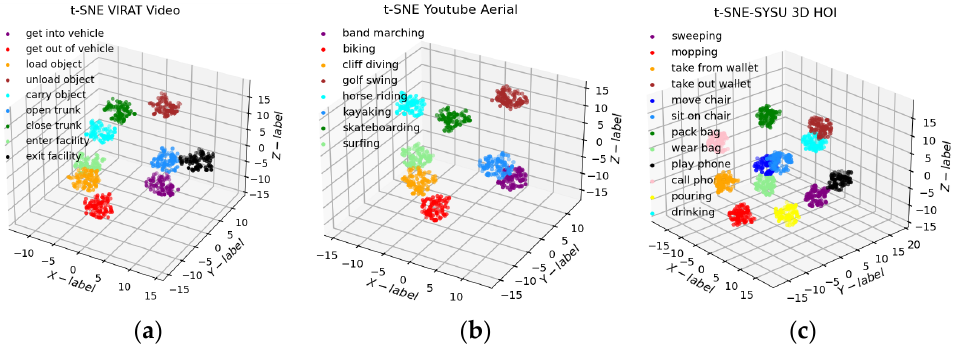
Figure 10. A few examples of t-SNE dimensionality reduction results over the ( a ) VIRAT Video dataset, ( b ) YouTube Aerial dataset, and ( c ) SYSU 3D HOI dataset.